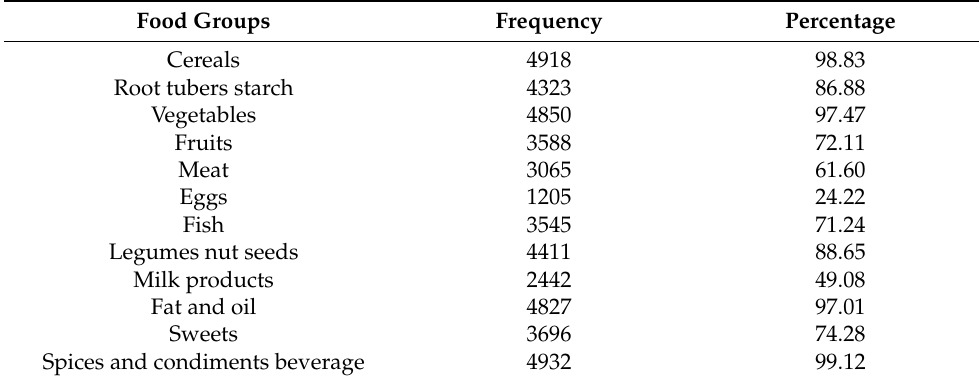
Table 7. Percentage of households consuming different food